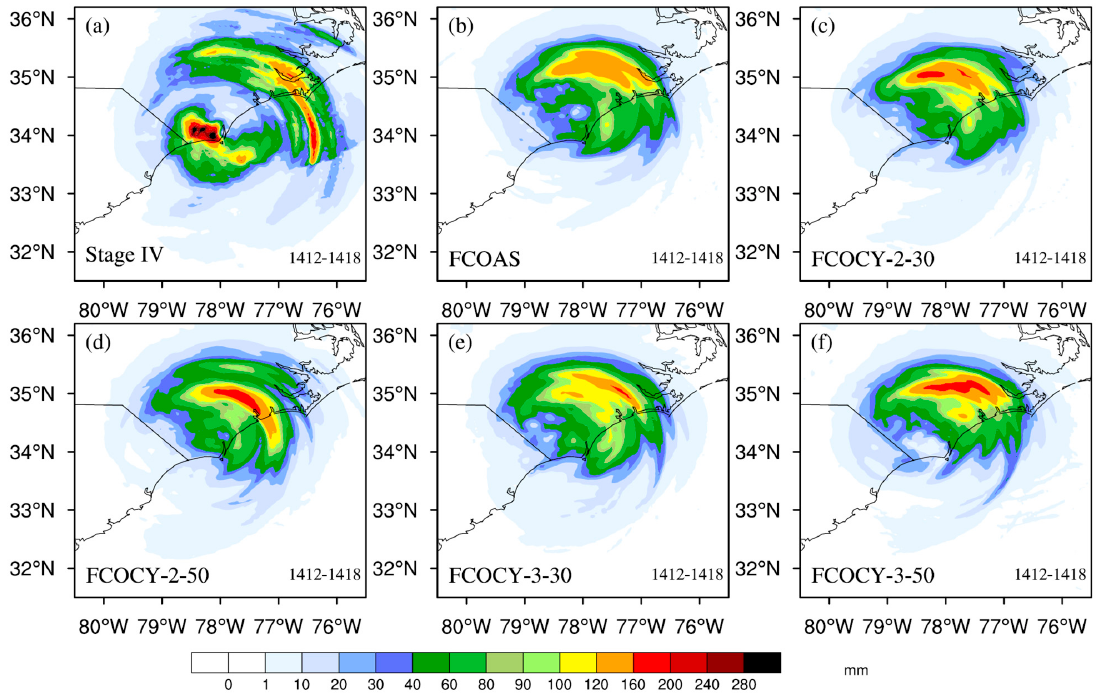
Figure 12. Six-hour accumulated precipitation (unit: mm) for Florence (from 1200 UTC to 1800 UTC on 14 September 2018) after landfall: ( a ) Stage IV2022 product; ( b – f ) forecast precipitation from experiments FCOAS, FCOCY-2-30, FCOCY-2-50, FCOCY-3-30, and FCOCY-3-50, respectively. For Hurricane Laura, since thinning distances of 50 km for V2.1 CYGNSS data and 30 km for V3.0 data perform better than in the other experiments, the comparison focuses on these results. First, it is found that assimilation of ocean-surface winds from both ASCAT and CYGNSS leads to a comparable track forecast in the first 30 h forecasts (Figure 9b). Exp. LCOCY-2-50 produces the best track forecast among all the experiments with CYGNSS data assimilation, with a track-error reduction of about 10% in the first 18 h (out of a 50 km track error with LCOAS). Improvement in the intensity forecast (Figure 13) is also evident. Specifically, the assimilation of CYGNSS V2.1 data with a 50 km thinning distance leads to intensity-error reduction in both MSLP and MSW compared to the experiment that assimilates the ASCAT data. Combining both data sources in the assimilation experiment LCOASCY-2-50 also leads to a positive influence on the intensity forecast. However, the assimilation of CYGNSS V3.0 data with a 30 km thinning distance leads to a slightly degraded intensity forecast in this case. Combining CYGNSS V3.0 data with a 30 km thinning distance with ASCAT data in the data assimilation experiment mitigates these negative impacts on the intensity forecasts of Laura.